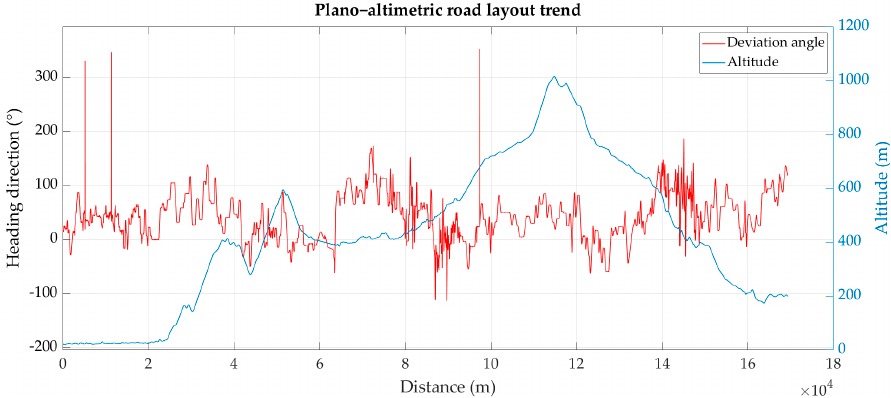
Figure 7. Heading direction and elevation trends along the HWY 4.